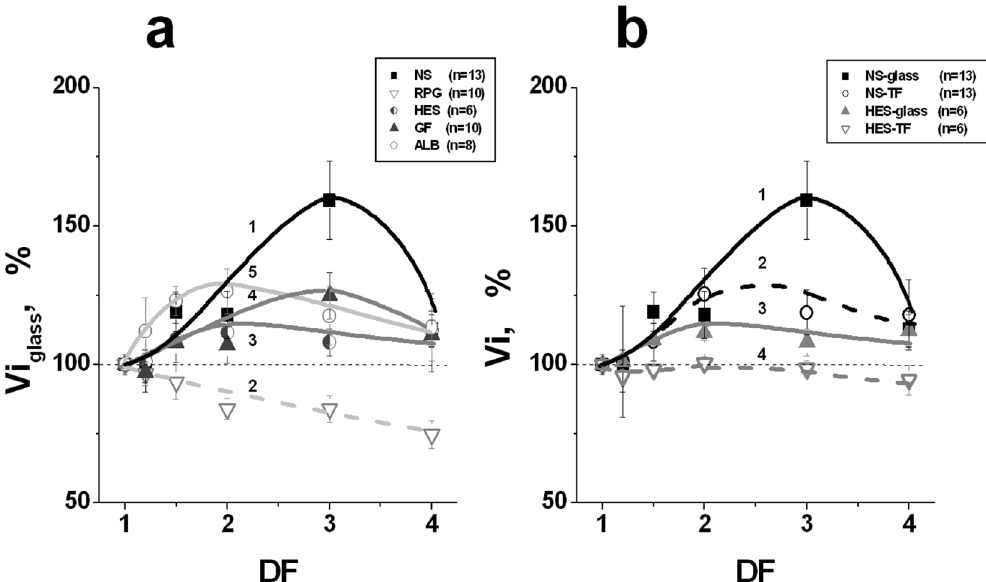
Figure 5. Initial clot growth rates at different levels of plasma dilution and under different types of coagulation activation. The results are shown in % relative to the corresponding rate in undiluted plasma. ( a ) – Clot growth rates in plasma diluted with: (1) – NS (n = 13); (2) – RPG (n = 10); (3) – HES (n = 6); (4) – GF (n = 10), and (5) – ALB (n = 8). Clotting was contact-activated. The difference between the starting undiluted plasma and the same diluted plasma was significant for all the PEs beginning from DF = 1.5 (ANOVA, P < 0.05 ). ( b ) – Clot growth rates in plasma diluted with NS (curves of 1 and 2, n = 13), or HES (curves of 3 and 4, n = 6). Coagulation was activated by glass (curves of 1 and 3), or by TF (curves of 2 and 4). The mean values ± SD are shown. DF (the dilution factor) is equal to the ratio of the final volume of diluted plasma to its initial volume. The difference between the initial undiluted plasma and the same diluted plasma was significant beginning from DF = 1.5 for both types of activation in the case of NS, but only for contact activation in the case of HES (ANOVA, P < 0.05 ). The difference observed between the two types of activation was significant at all DFs for HES, but only at DF = 3 for